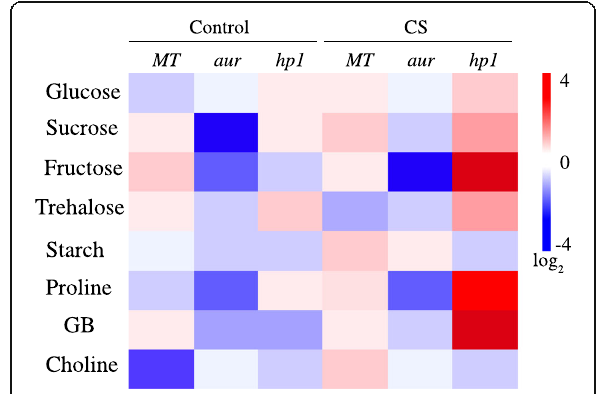
Fig. 6 Heat map of selected set of stress-related compounds in leaves from wild-type genotype (MT) and aurea ( aur ) and high pigment1 ( hp1 ) mutants of tomato under control and chilling stress (CS) conditions. Red color represents higher relative concentration and blue color represents lower relative concentration. Scale is the